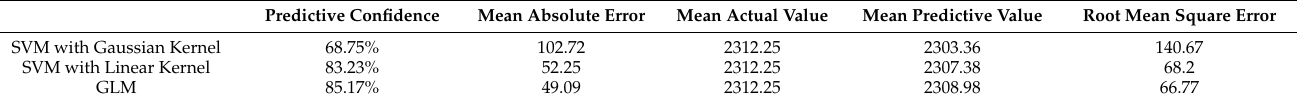
Table 4. Results of the main metrics after generating models for the cohort of weekdays.